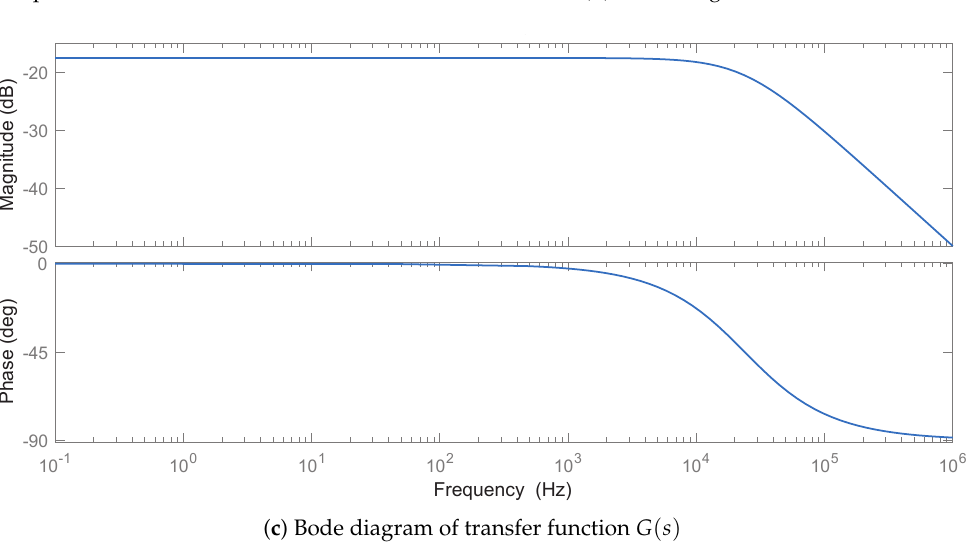
( c ) Bode diagram of transfer function G ( s ) Figure 1. Characteristics of the inertial